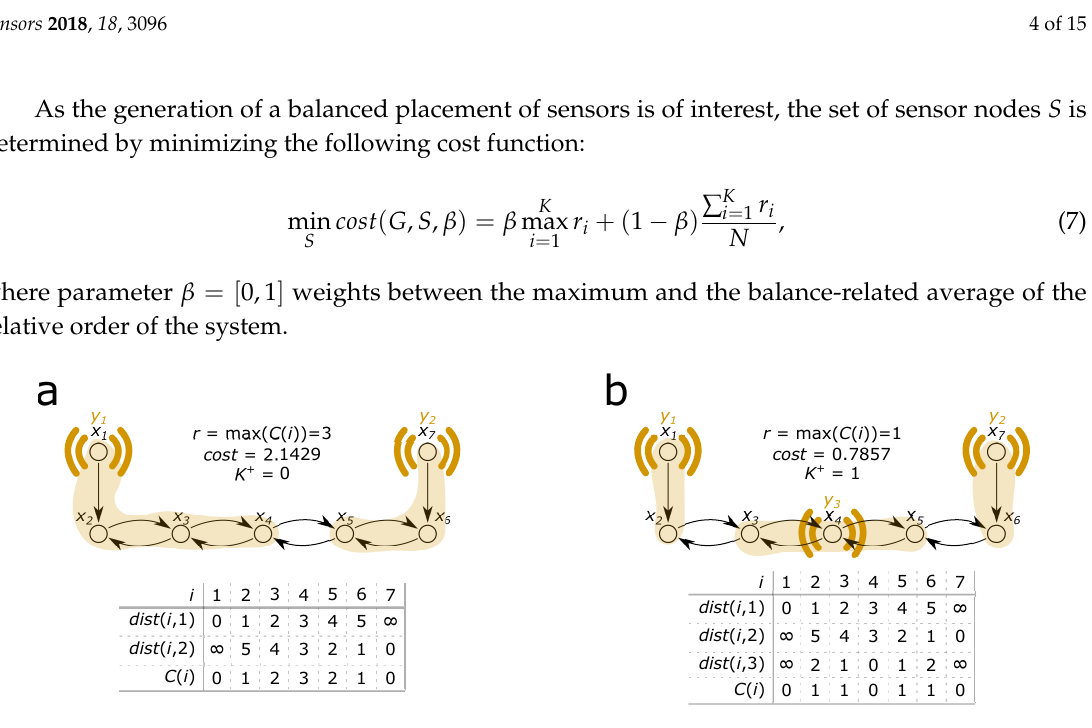
Figure 1. Illustration of the concept of relative degrees of the state variables and how one additional sensor decreases the relative degree of the system. ( a ) relative degrees in the case of two sensors that are necessary to grant observability; ( b ) relative degrees in the case of one additional